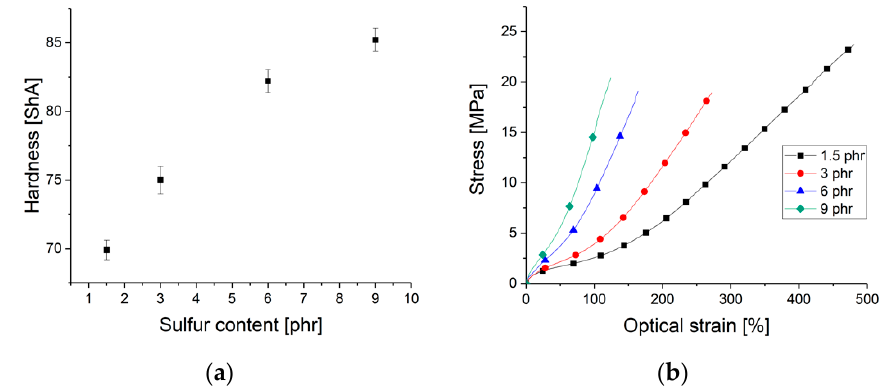
Figure 2. Nitrile butadiene rubber: ( a ) Shore A hardness in dependence on the sulfur content according to DIN ISO 7619; ( b ) stress–strain curves for different sulfur contents.